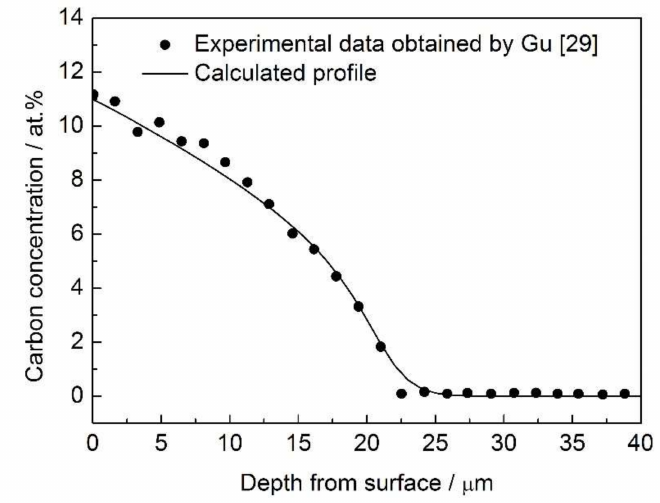
Figure 3. Experimental and calculated carbon concentration–depth profiles of AISI 316L carburized at 450 ◦ C for 42